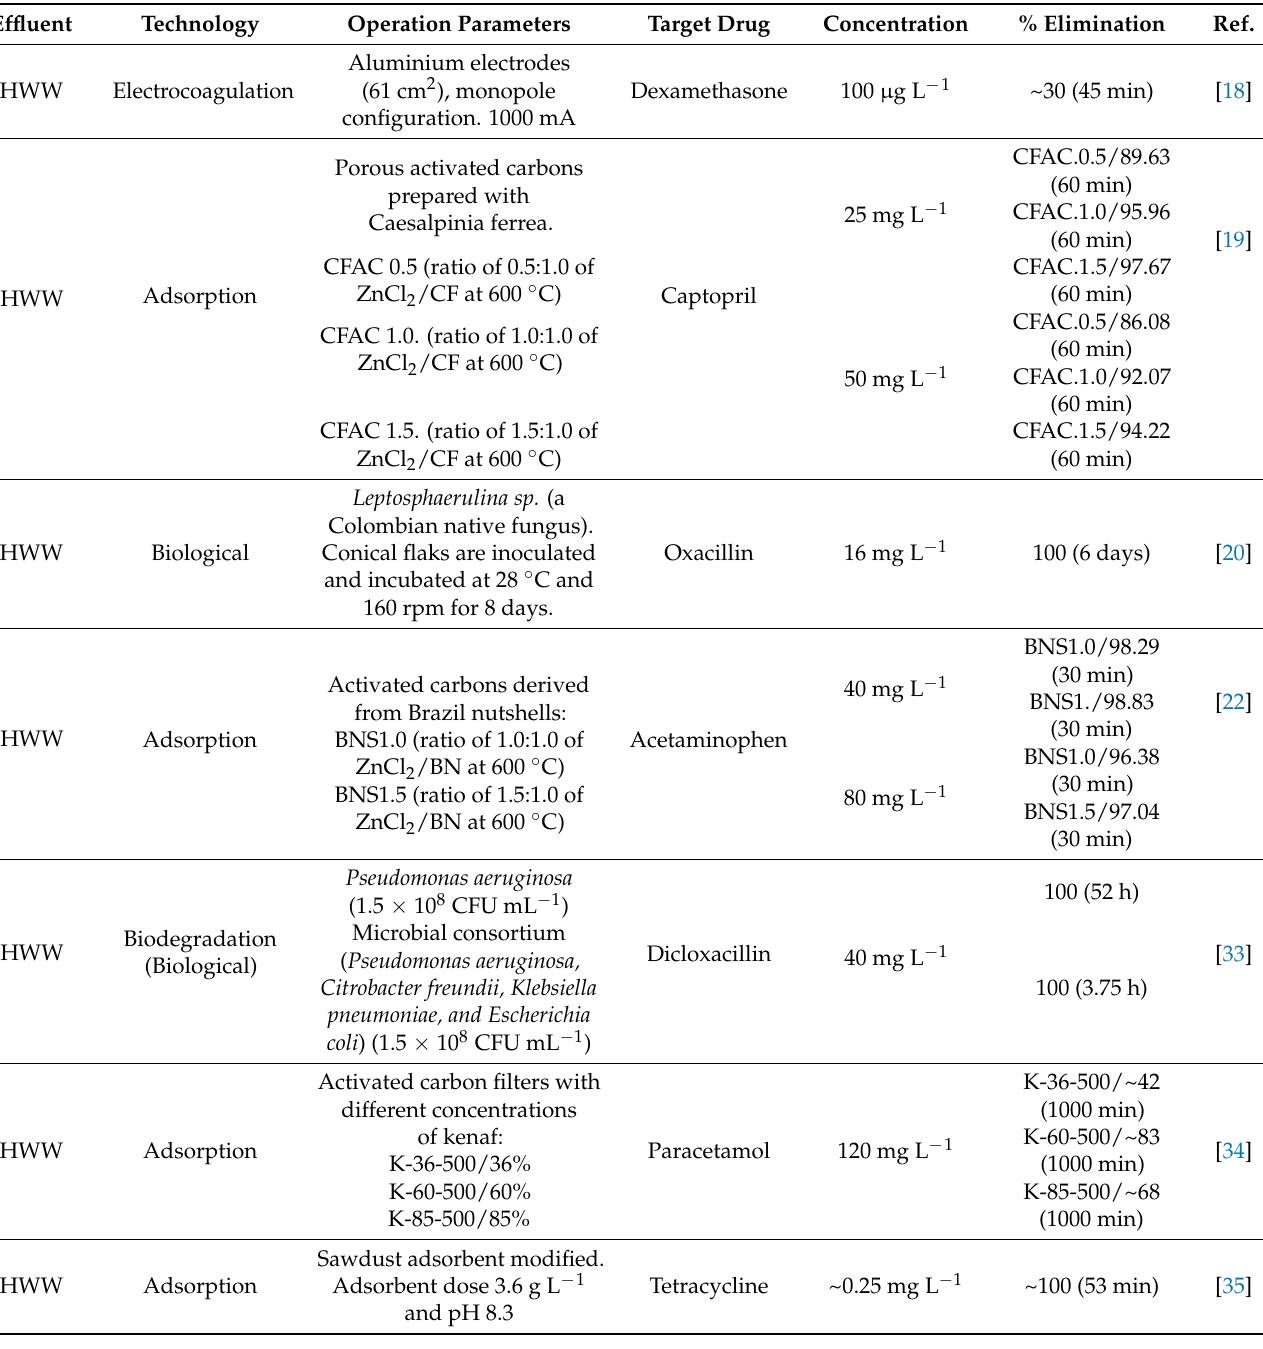
Table 2. Conventional processes for the removal of PhCs in